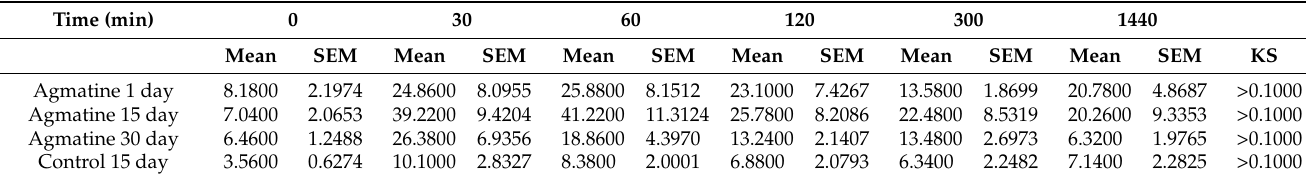
Table 10. Plasma agmatine levels. Mean and standard error of the mean (SEM) of plasma agmatine levels (ng/mL) for each treatment (agmatine 1st, 15th, 30th day; control 15th day) and time (0, 30,